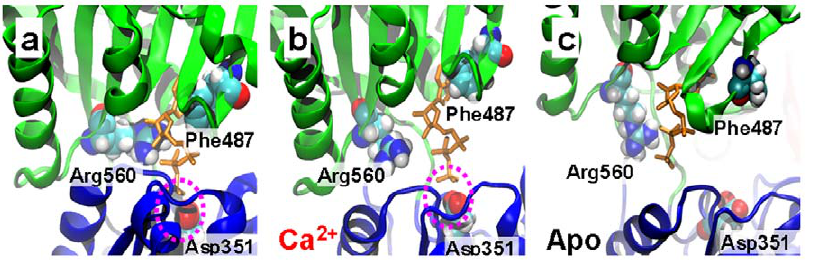
Figure 5. Active site geometry of SERCA in atomic detail. ( a ) Crystal structure of SERCA bound to calcium and AMPPCP (orange sticks). Simulations at 500 ns of ( b ) Ca 2 + -bound and ( c ) Apo SERCA. In both cases, the predicted orientation of AMPPCP was obtained by using rigid-body docking simulations. Residues that are necessary for nucleotide binding (Phe487 and Arg560) and autophosphorylation (Asp351) are shown as van der Waals spheres. The N and P domains are rendered as green and blue ribbons, respectively. The dashed magenta ovals highlight the proximity between the c -phosphate of AMPPCP and the carboxyl group of Asp351 in a and b , but not in c .